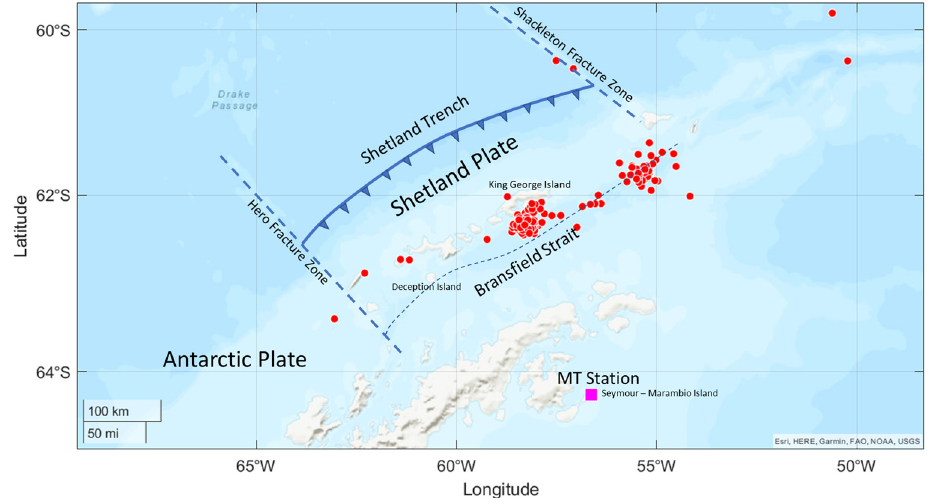
Figure 1. The main tectonic features are in the influence area of the Shetland and Antarctic plates. Red points correspond to earthquakes reported by the USGS with m b > 4.0, which have epicentral distances between 200 and 300 km from the MT station installed in the Seymour–Marambio Island (purple square). The axis of the Bransfield Basin is suggested by a thin–dashed line, following the trend of the Bransfield Strait.